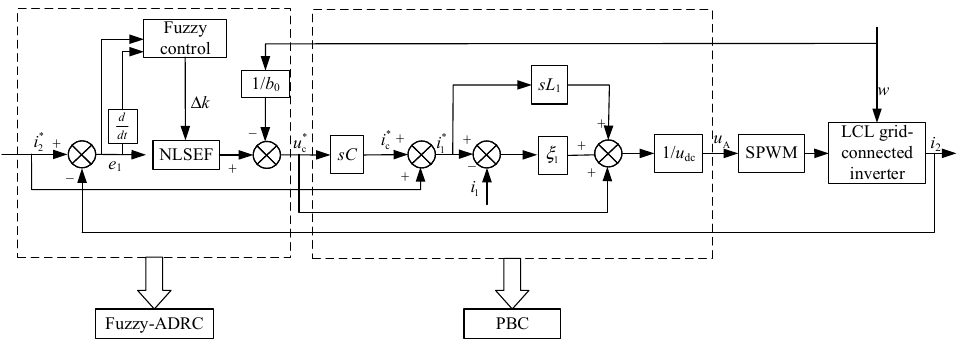
Figure 5. Single-phase weak grid LCL grid-connected inverter control block diagram.